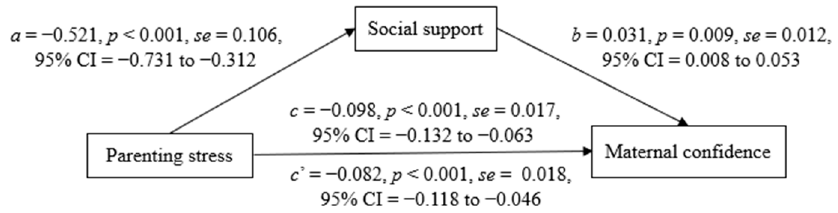
Figure 1. Effects of parenting stress on maternal confidence with the mediator of overall social support, adjusted for infant age by month ( N = 205).